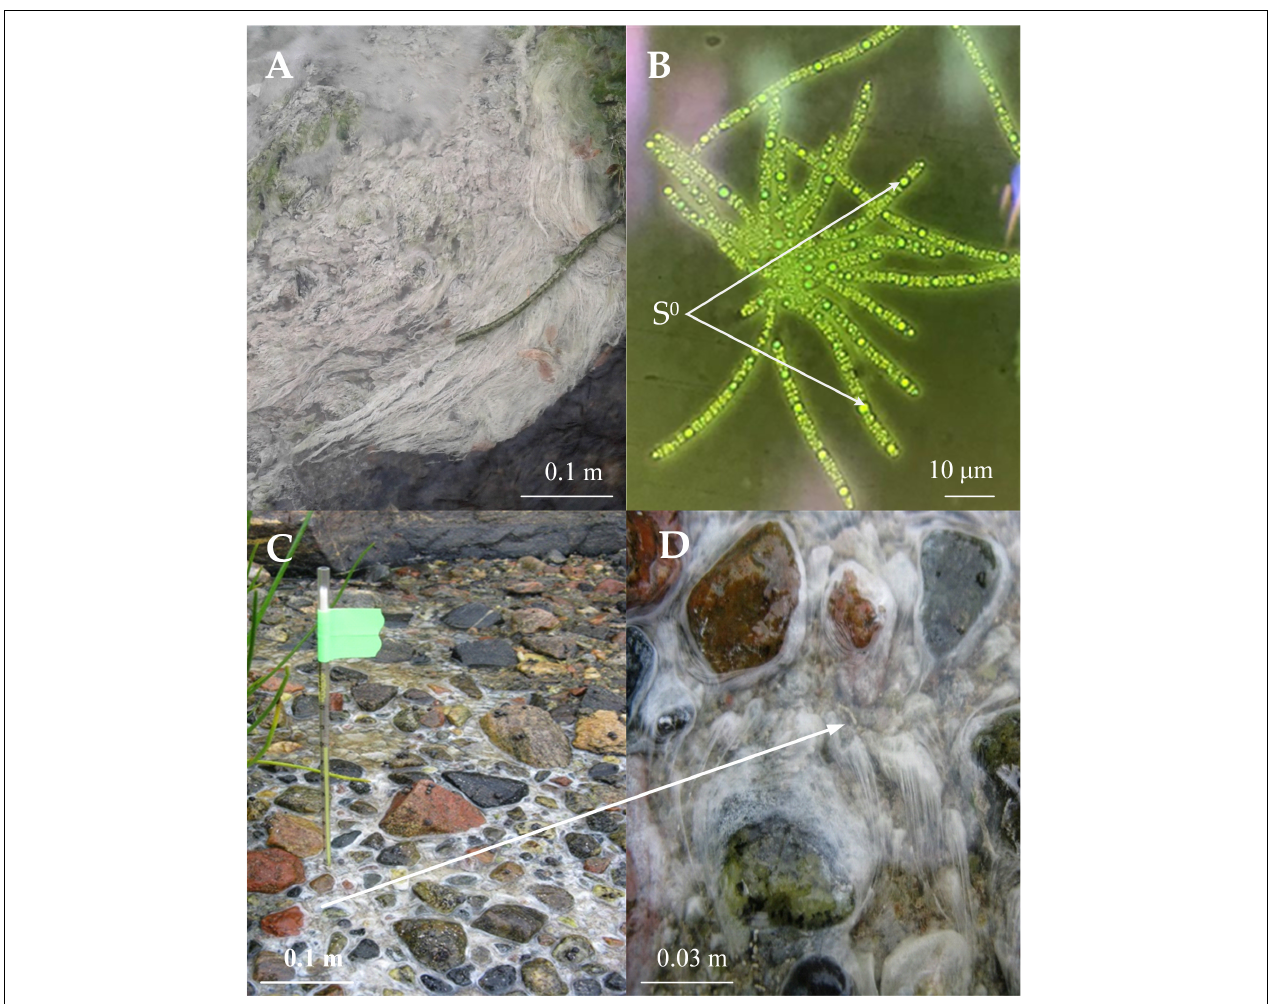
FIGURE 1 | The biotope properties where Thiothrix samples of Thiothrix sp. Ku-5 (A) and AS (C) and (D) were collected and morphology of Thiothrix sp. Ku-5 cells: rosette formation; inclusion of elemental sulfur in cells (B) . Cell morphology was observed by using an Olympus CX41 microscope equipped with a phase-contrast device. The white arrow indicates the scaled area in (C) with Thiothrix